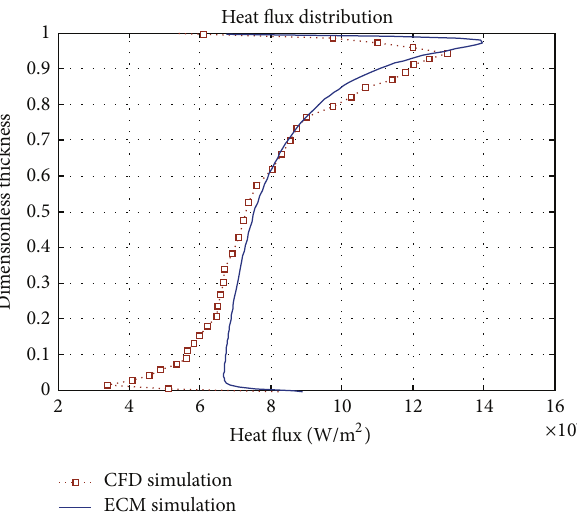
Figure 14: PECM and CFD predicted temperature profiles across the layer at 5